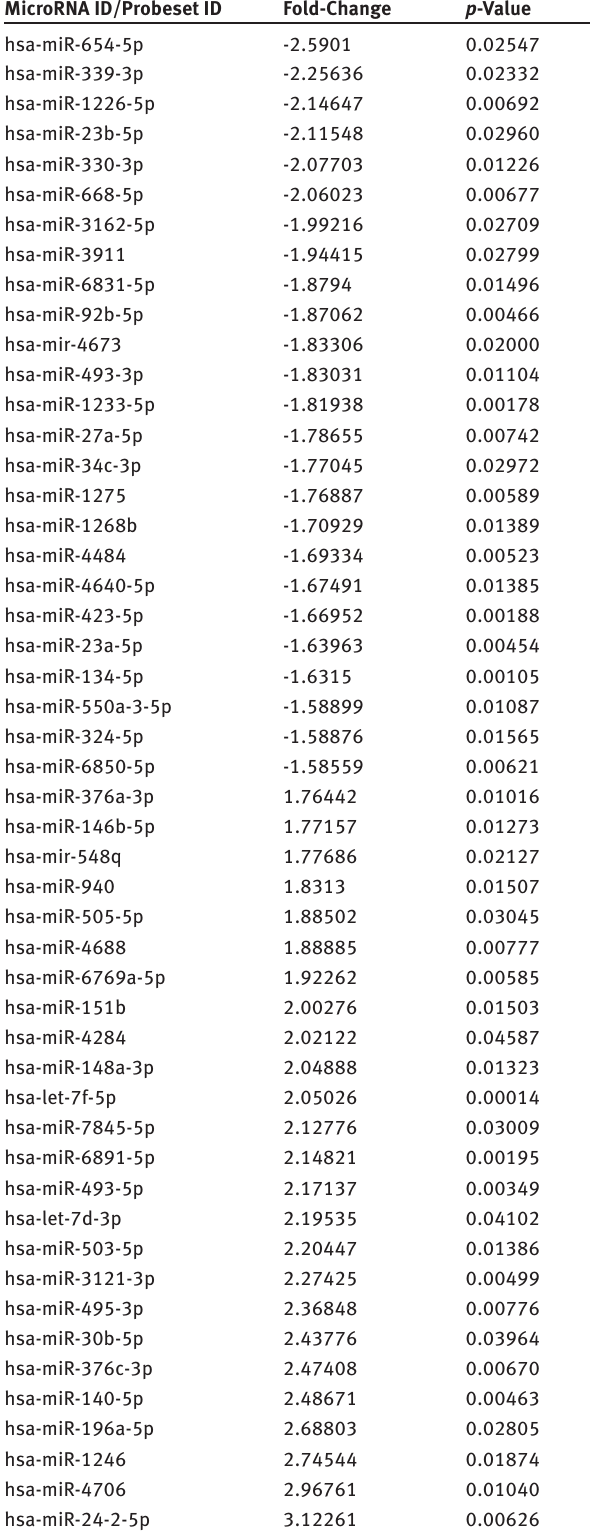
Table 1: Select (top 50) differentially expressed miRNAs in response to SDF-1 treatment in human